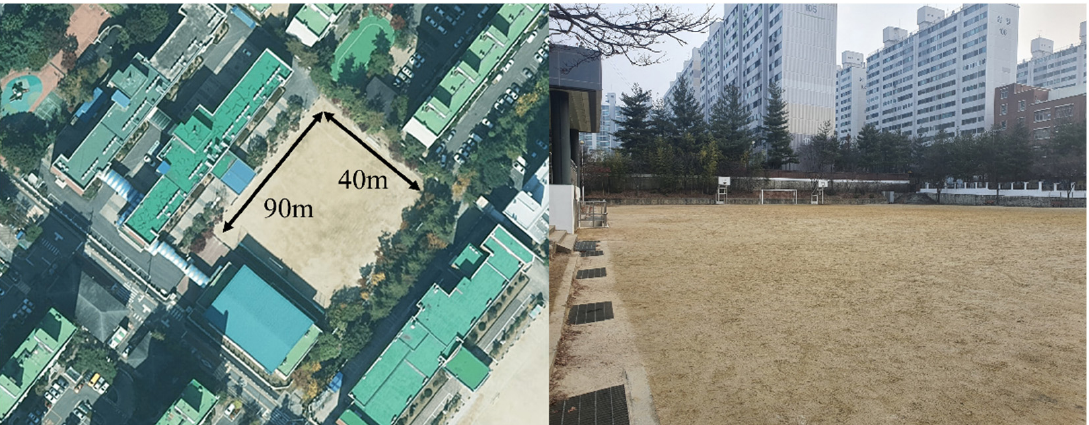
Figure 8. Outdoor data collection environment. Table 1. Deep learning model hyperparameters.